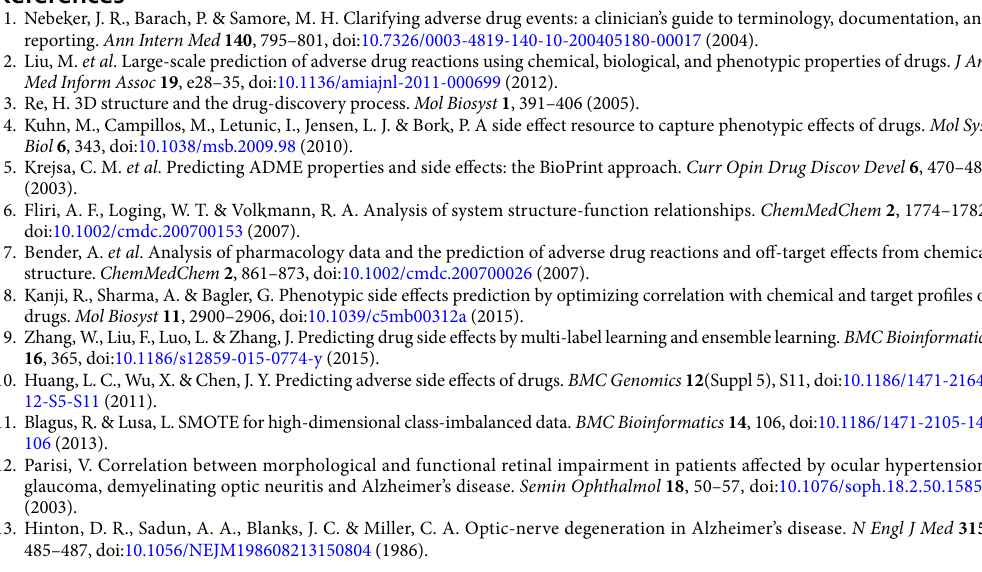
Evaluation measures for predictive models. A total of 176 machine learning models were generated for 22 neurological ADRs which were evaluated using receiver operating characteristic (ROC), accuracy, precision, recall and F-measure. ROC curve is a graphical plot of true positive rate (or sensitivity or recall) vs false positive rate (1-specificity). True positive rate (TPR = TP/(TP + FN)) is the proportion of correctly identified positives while false positive rate is the proportion of correctly identified negatives. Accuracy (Q) is the proportion of cor- rectly identified instances (Q = TP + TN/(TP + TN + FP + FN)). Precision (P) is the fraction of correctly identi- fied positives against all the predicted positives (P = TP/(TP + FP)). The performance for the 176 models for 22 neurological ADRs was averaged for each of the class of the properties, biological, chemical, phenotypic and a combination of all the three properties.